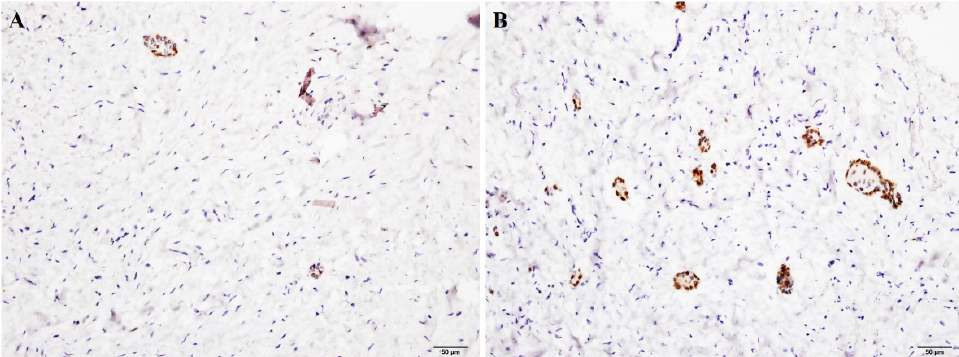
Figure 2. Remnants of odontogenic epithelium in dental follicle containing SOX2+ cells. (Immuno- histochemical staining showing SOX2+ cells in dental follicular tissue with ( A ) few remnants and ( B ) more remnants.) (Original magnification × 200). Table 2. Expression status of SOX2 in remnants of odontogenic epithelial rests.